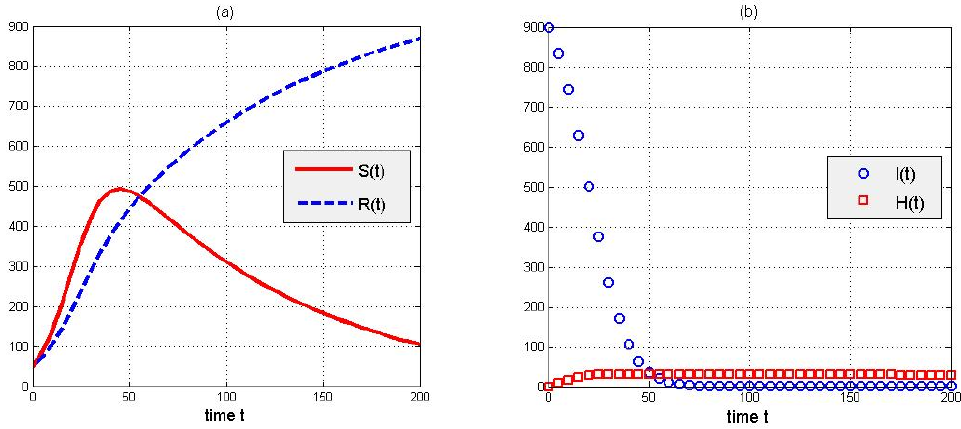
Figure 3. ( a ) The time series for spreaders and stiflers under R 0 > 1 ; ( b ) The time series for ignorants and hibernators under R 0 > 1